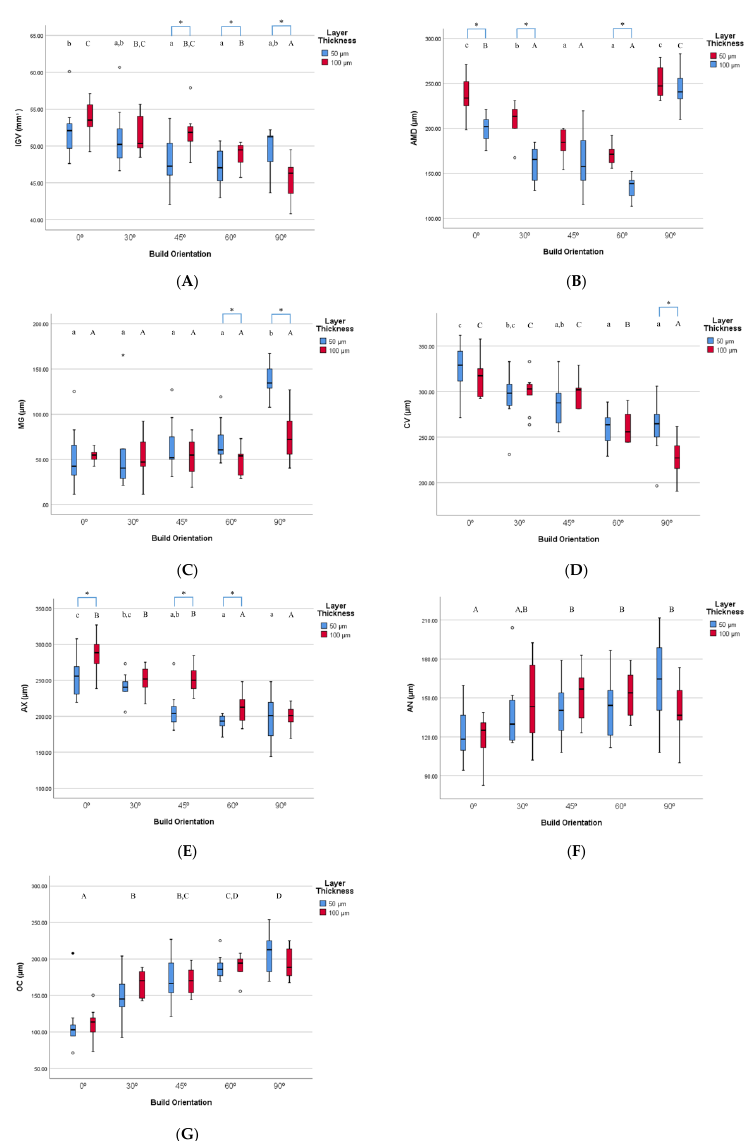
Figure 6. ( A ) The internal gap volume (IGV), ( B ) the absolute marginal discrepancy (AMD), ( C ) marginal gap (MG), ( D ) internal gap length at cervical area (CV), ( E ) internal gap length at axial wall area (AX), ( F ) internal gap length at axio-occlusal angle area (AN), ( G ) internal gap length at occlusal area (OC) for various 3D printing groups. Di ff erent lowercase letters in the 50 µ m layer thickness group indicate statistically significant di ff erences. Di ff erent uppercase letters in the 100 µ m layer thickness group indicate statistically significant di ff erences. * indicate statistical significance between di ff erent layer thickness group in same build